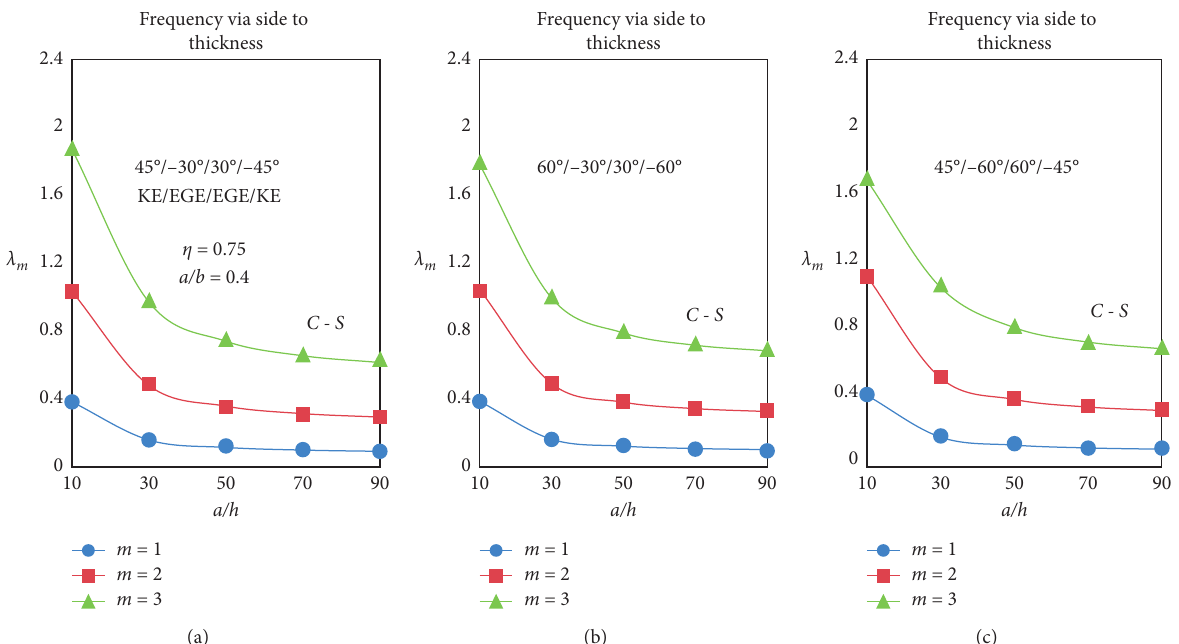
Figure 8: Influence of side-to-thickness ratio on frequency parameter value of 4-layered plates under C-S support condition.